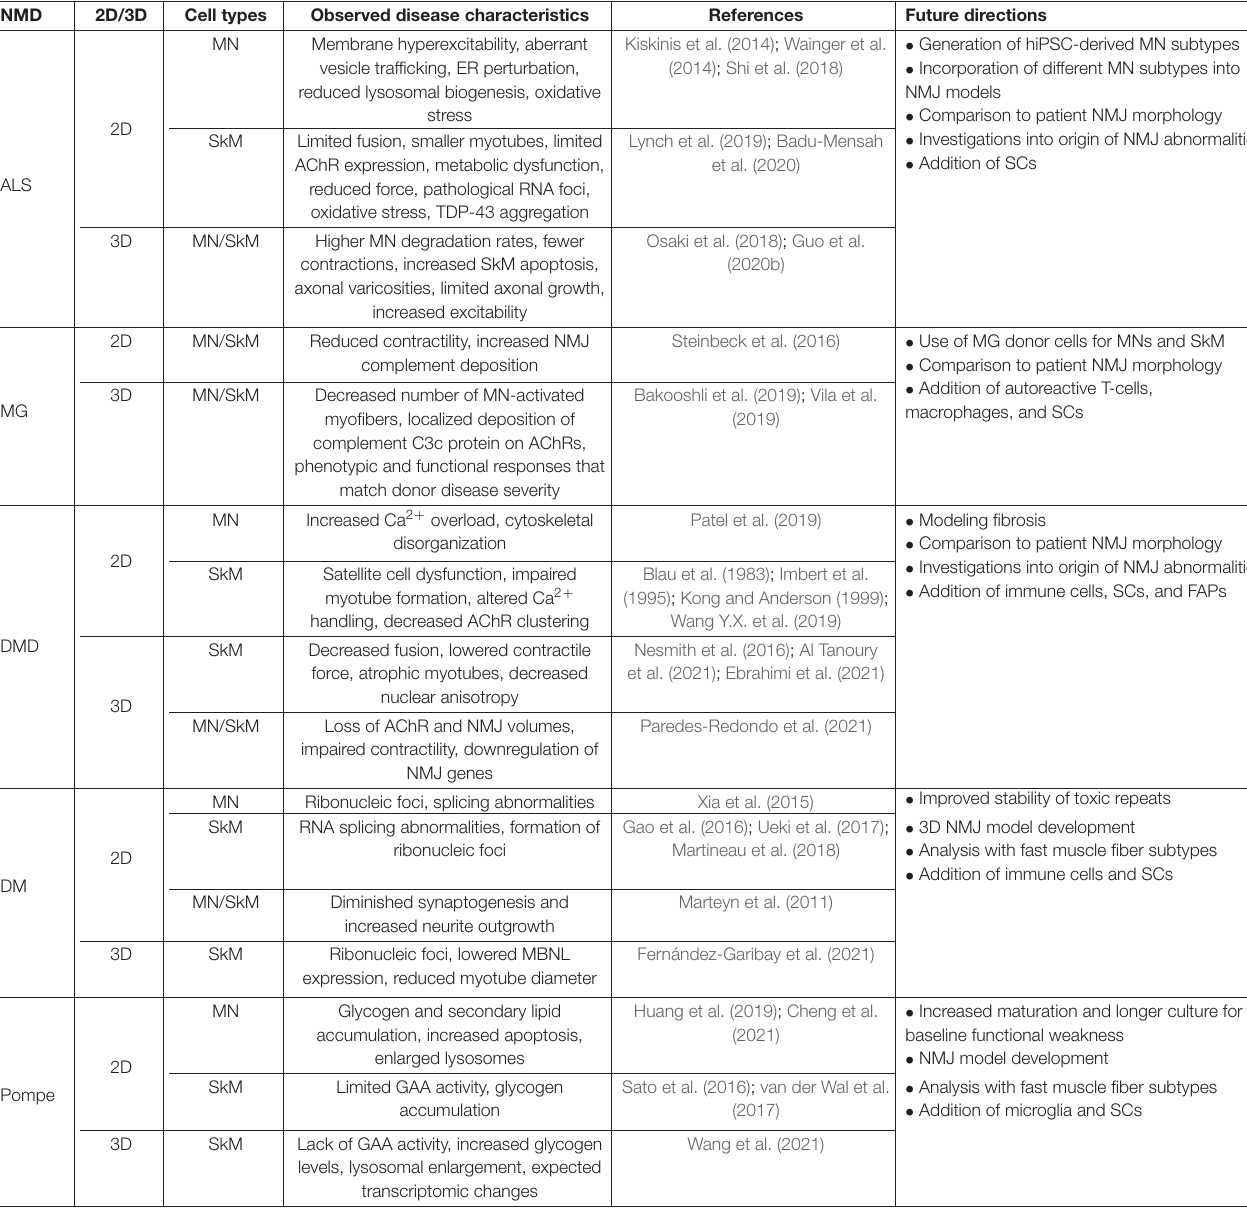
TABLE 1 | Selected in vitro human models of